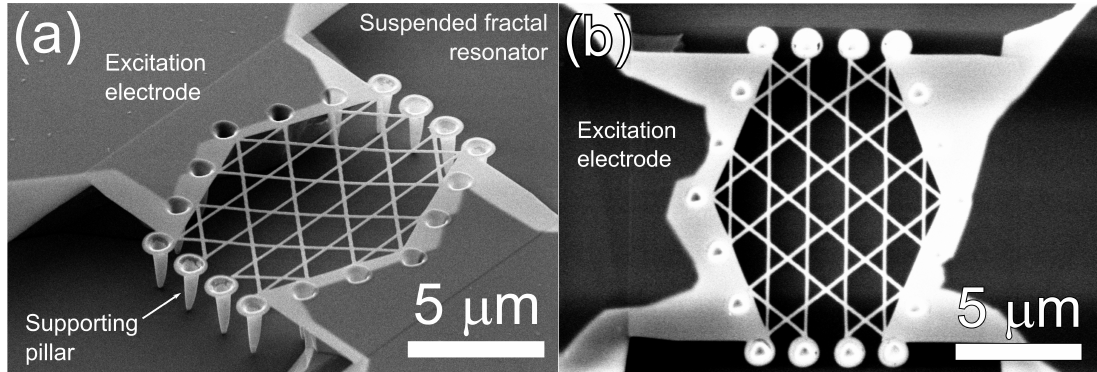
Figure 1. SEM images of the fractal nano structure: ( a ) 45 degree tilted SEM image of the suspended fractal resonator. ( b ) Top-view SEM image of the suspended